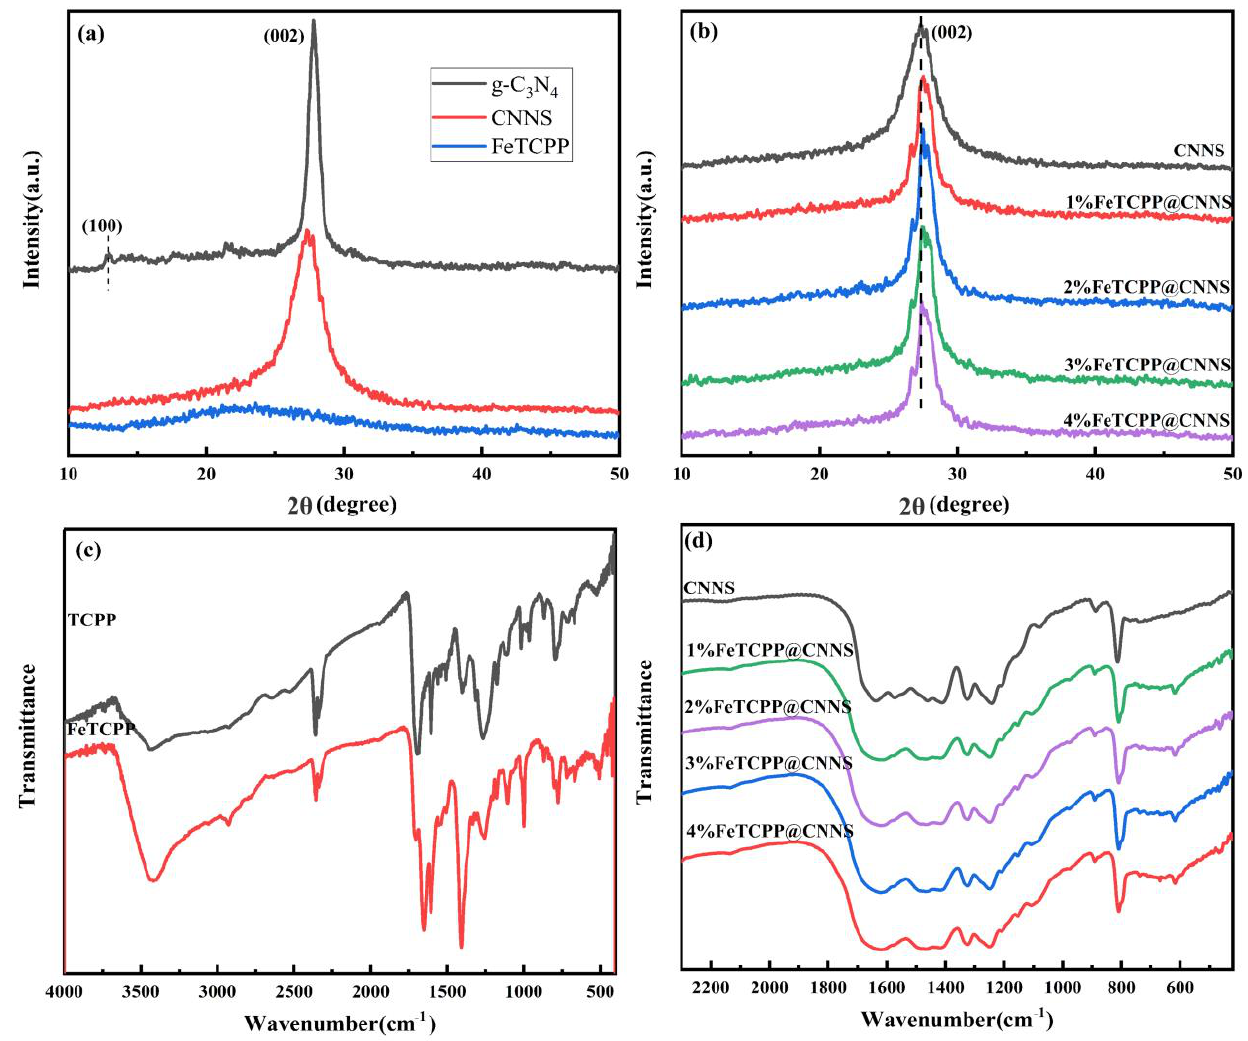
Figure 2. XRD spectra of ( a ) g-C 3 N 4 , CNNS, and FeTCPP and ( b ) FeTCPP@CNNS composites; FTIR spectra of ( c ) TCPP and FeTCPP and ( d ) CNNS and FeTCPP@CNNS composites.